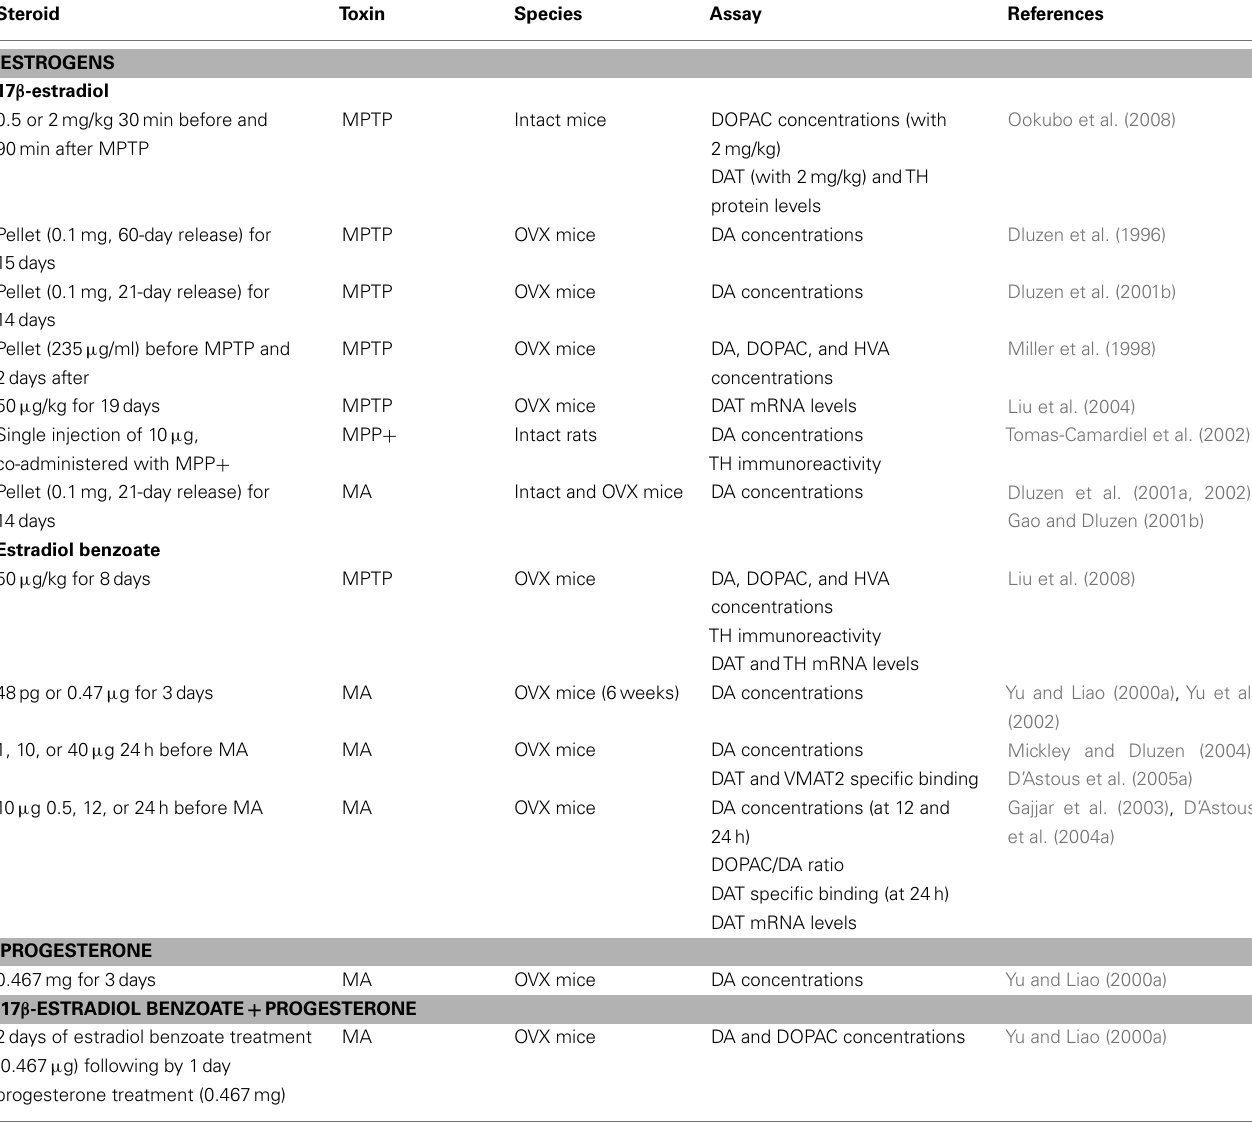
Table 1 | In vivo studies and neuroprotection in female rodents: studies showing protection of DA markers. Steroid Toxin